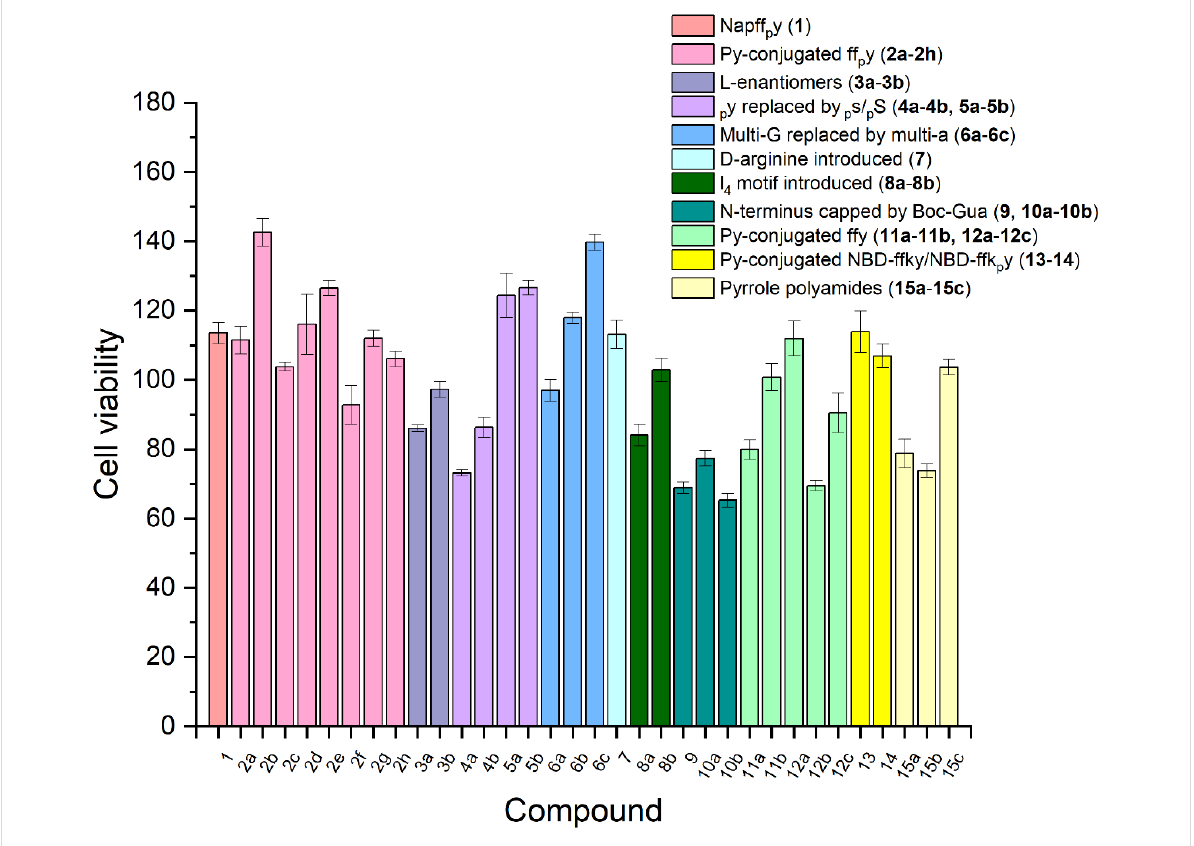
Figure 1: Cell viability of HeLa cells treated with 200 μ M of each compound for 24